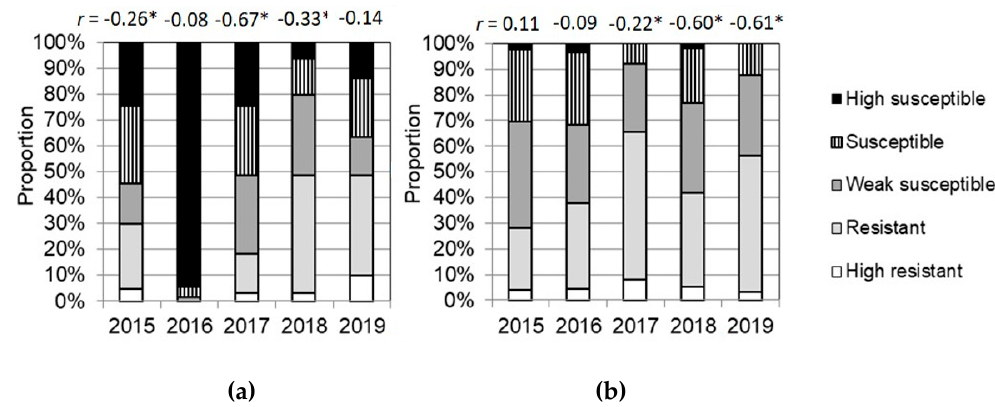
Figure 2. Distribution of introgressive lines of spring common wheat with genetic material of Thinopyrum ponticum on resistance to Septoria leaf ( a ) and ear ( b ) blotch and correlations between grain yield per plant and disease severity ( r ). (Omsk, Russia, field conditions, 2015–2019). * reliable (at p ≤ 0.05).